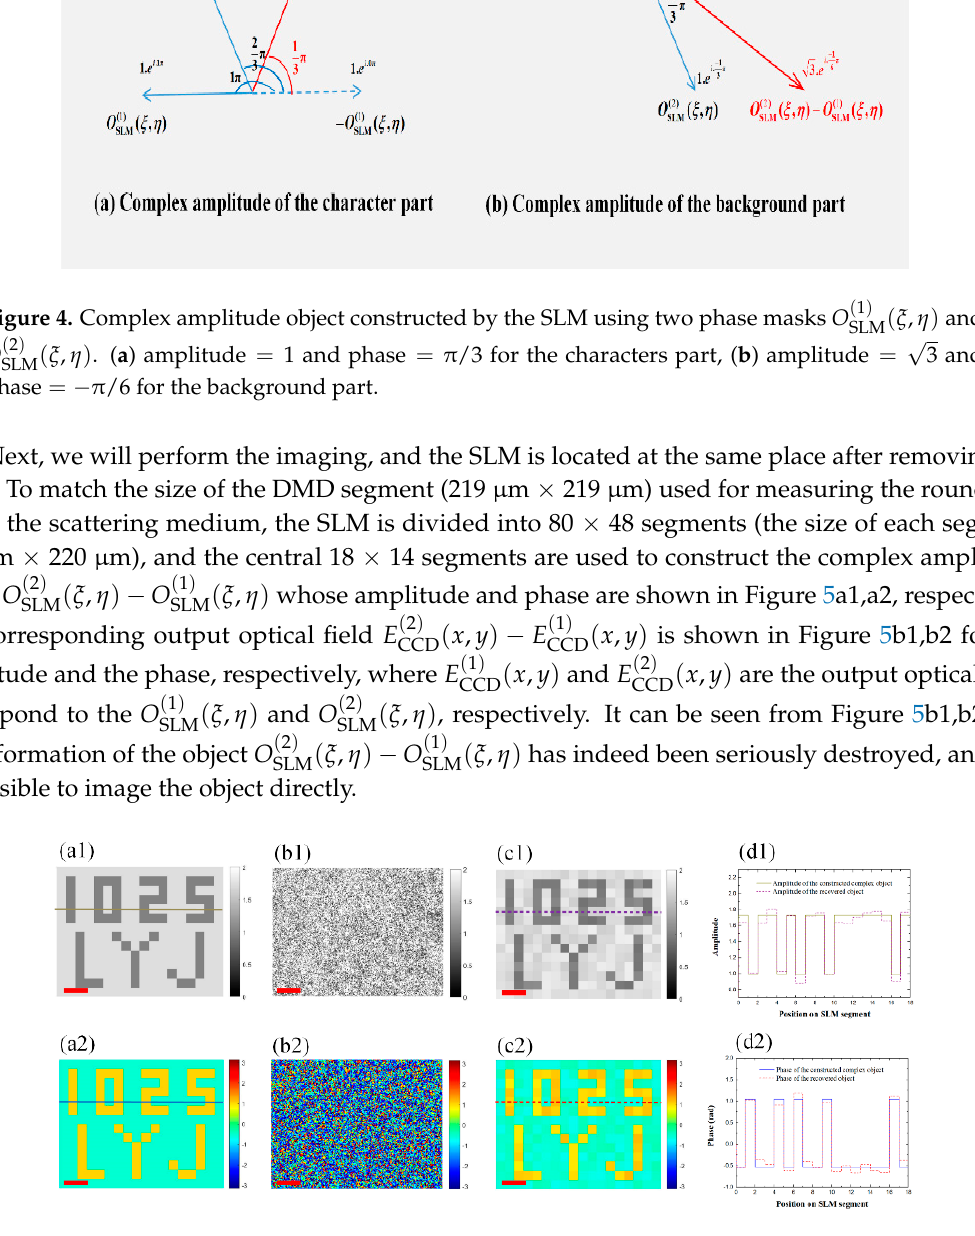
Figure 5. Imaging the complex amplitude object. ( a1 , a2 ) Amplitude and phase of the object ( 2 ) ( ξ , η ) − O ( 1 ) ( ξ , η ) , respectively. ( b1 , b2 ) Amplitude and phase of the corresponding output O SLM SLM ( 2 ) ( x , y ) − E ( 1 ) ( x , y ) , respectively. ( c1 , c2 ) Amplitude and phase of the recovered optical filed E CCD CCD object, respectively. ( d1 ) Section profiles corresponding to the lines in ( a1 , c1 ); ( d2 ) section profiles corresponding to the lines in ( a2 , c2 ). Scale bars indicate 400 µ m in ( b1 , b2 ) and 600 µ m in ( a1 , a2 , c1 , c2 ). Gray bar: amplitude. Color bar: phase in